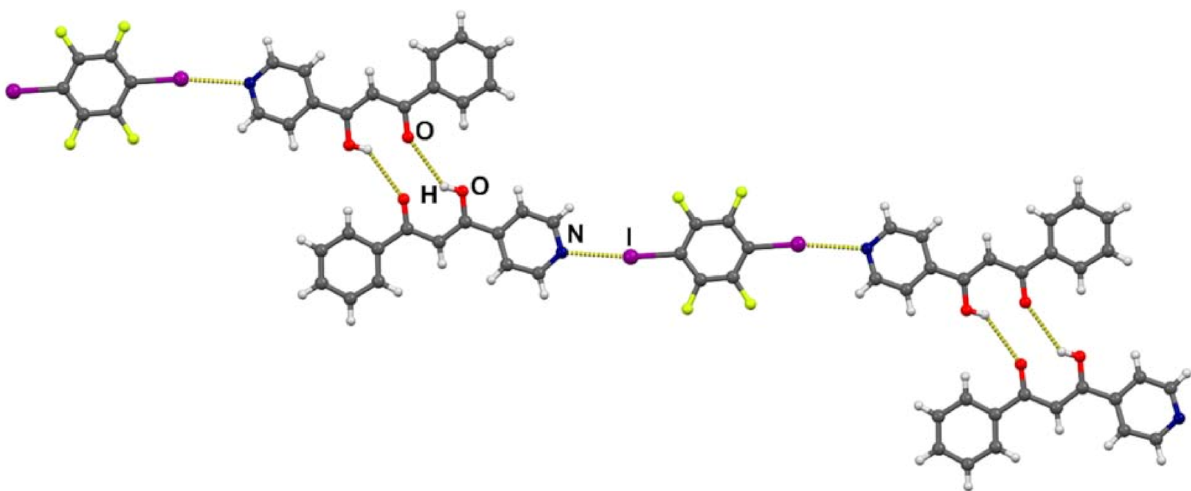
Figure 6. Halogen bonded molecular complex in ( b4pm ) 2 ( 14tfib ). Interconnected into chains through O − H ··· O hydrogen bonds. Hydroxyl hydrogen atoms were found from the electron difference map.